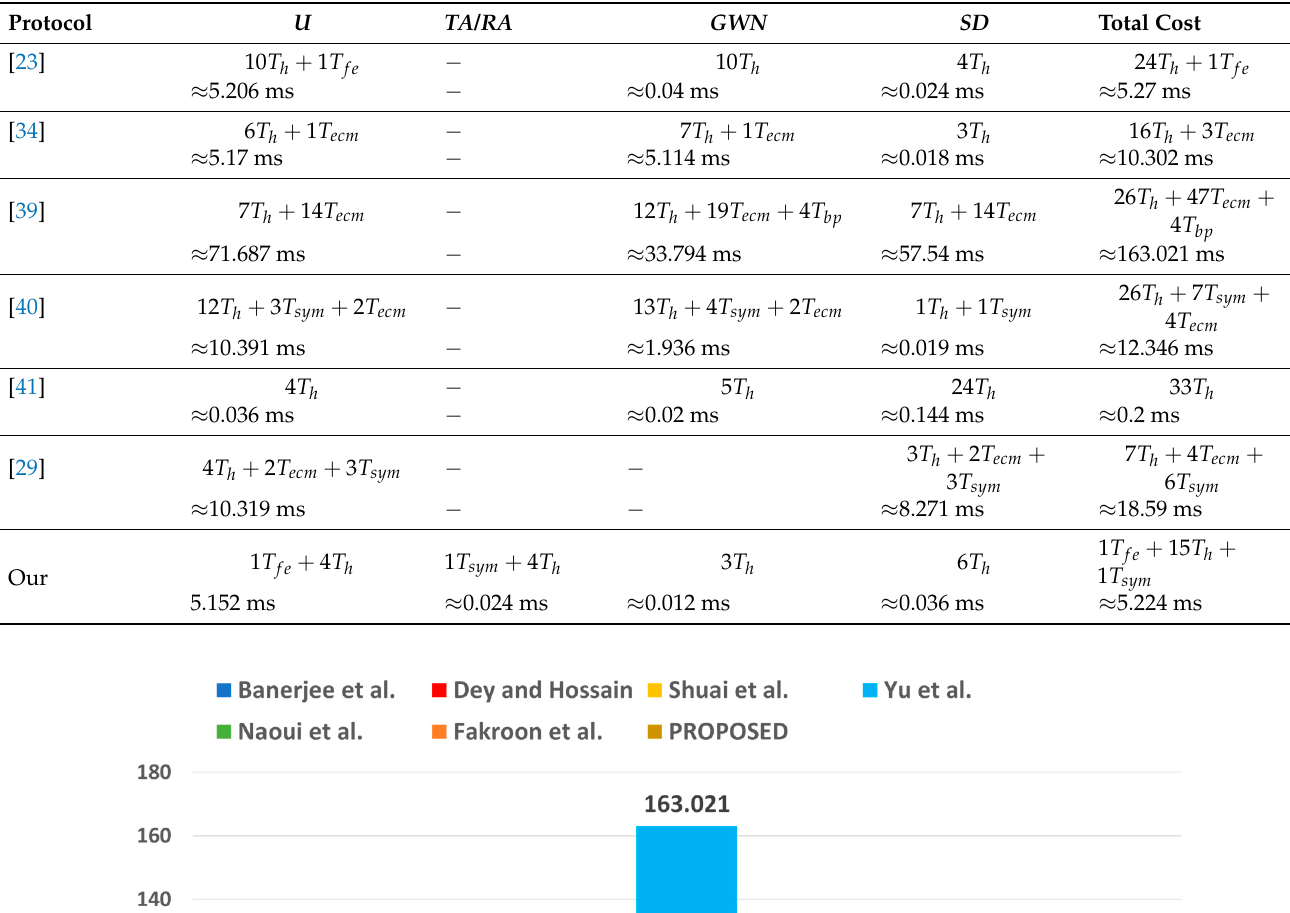
Table 9. Computation cost comparison.